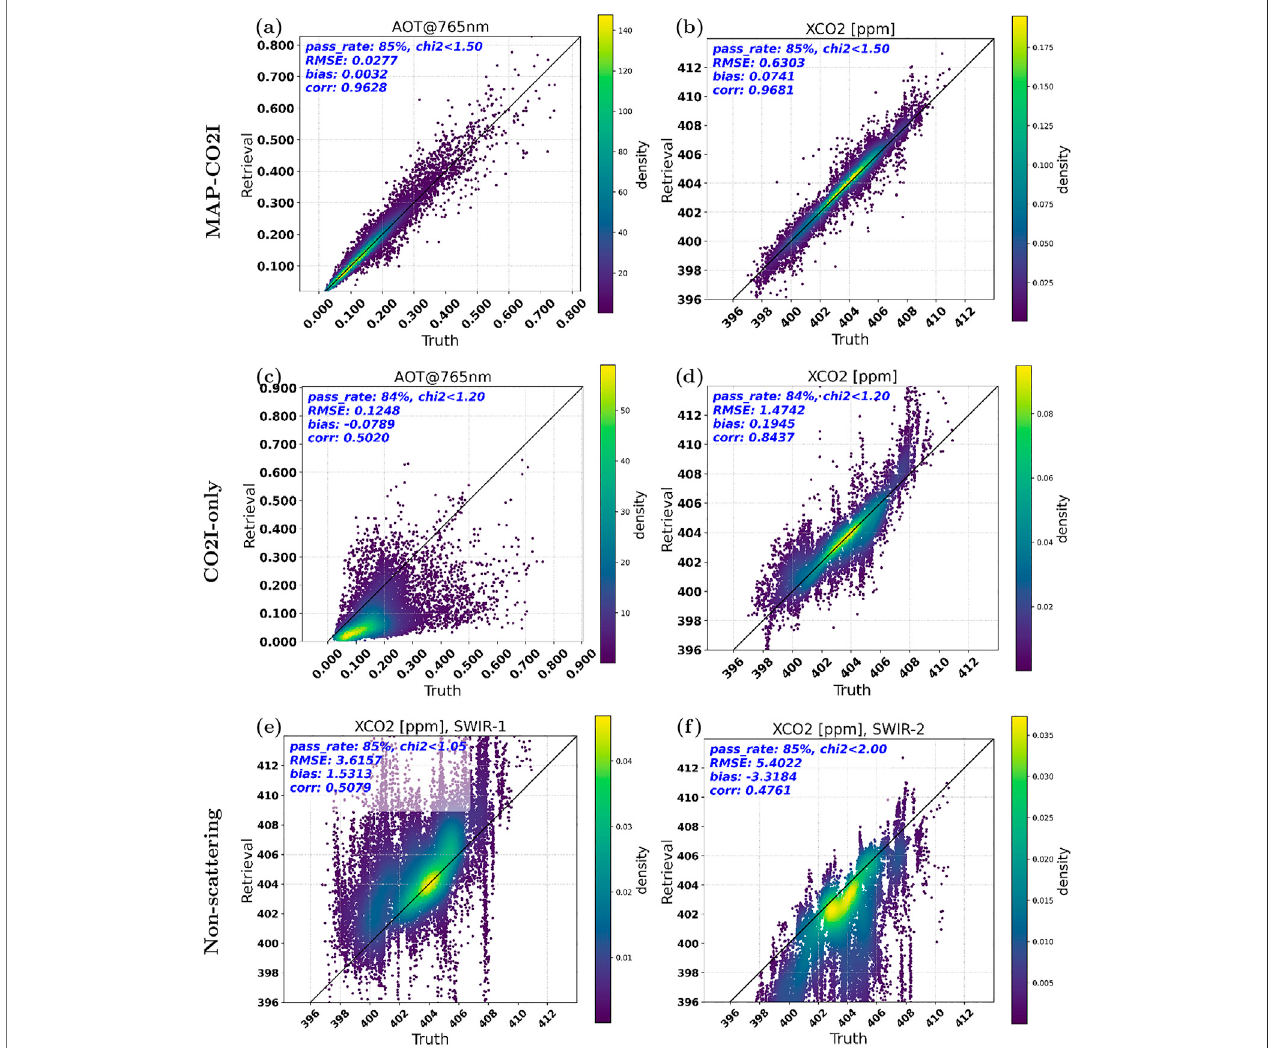
FIGURE5| Thetoppanel showsthe MAP-CO2I retrievalsofAOTat 765nm (A) and XCO 2 (B) ,and themiddlepanel theCO 2 I-onlyretrievals ofAOT (C) andXCO 2 (D) at non-scattering retrieval fi ltered cirrus-free pixels by not retrieving cirrus. The bottom panel shows the non-scattering retrievals of XCO 2 at SWIR-1 (E) and SWIR-2 bands (F)